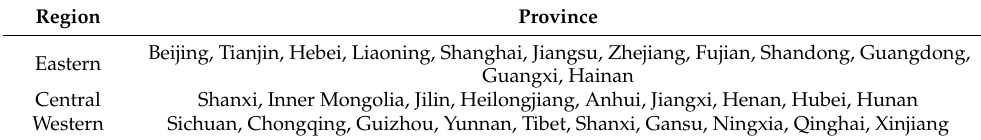
Table A1. Geographical distribution of